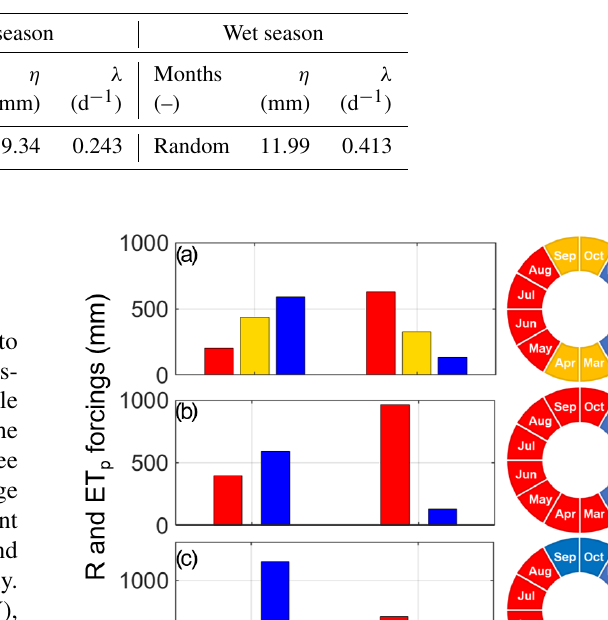
Table 3. Scenario set up in the dynamic approach. Duration and Poisson distribution parameters ( η and λ ) are reported in the dry and wet seasons.